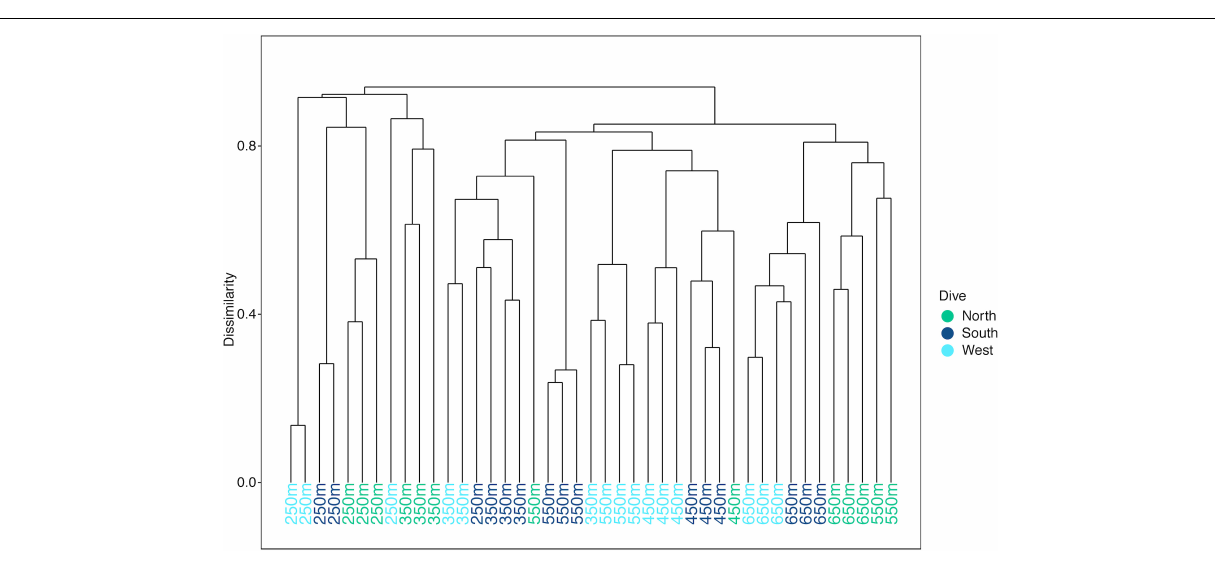
(0.81–0.88), and 24.8% of all morphospecies were found on only one side of the seamount, 24.9% were found on only two sides, and 50.3% of all morphospecies were found on all three